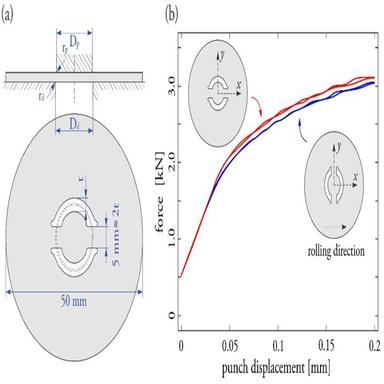
Two-bridge through-thickness shear test. (a) A schematic illustration of the shearing setup. (b) Shearing force versus punch displacement curve. The specimens were preloaded up to 0.5 kN to minimise initial clearances between the specimen and tools. Red and blue curves represent the bridge orientated in the rolling and transverse direction, respectively. The results show that the shear resistance is slightly higher when the bridge is orientated in the rolling direction, consistent with the prediction of th